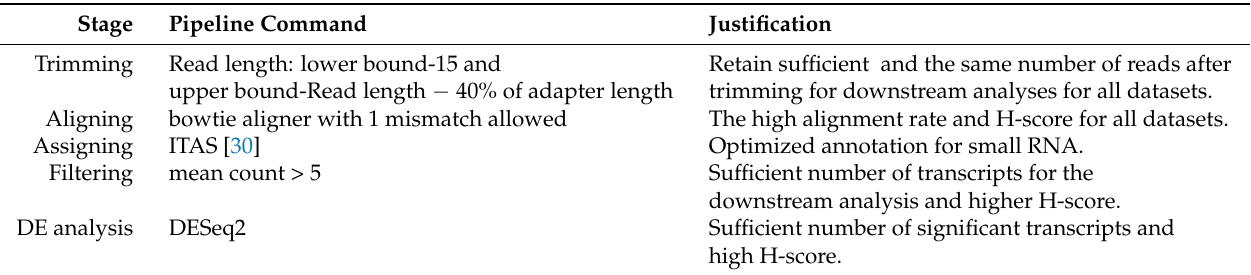
Table 2. Recommended pipeline for sRNA analyses.